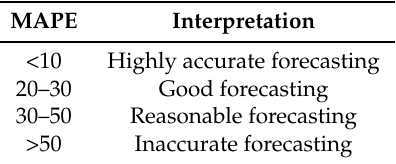
Table 3. Interpretation of typical Mean Absolute Percentage Error (MAPE) values.